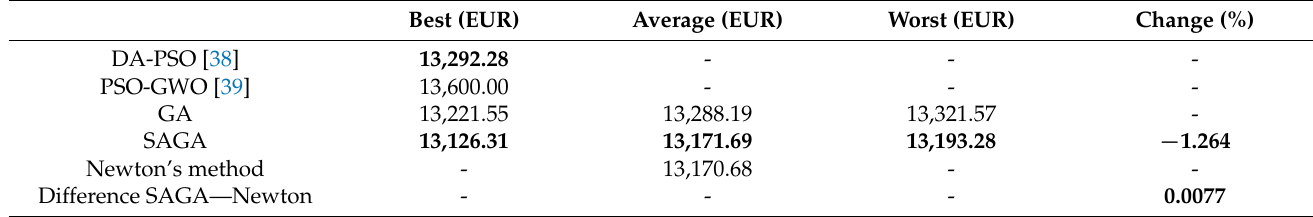
Table 3. Optimal generation scheduling of the test system 2 [38,39].